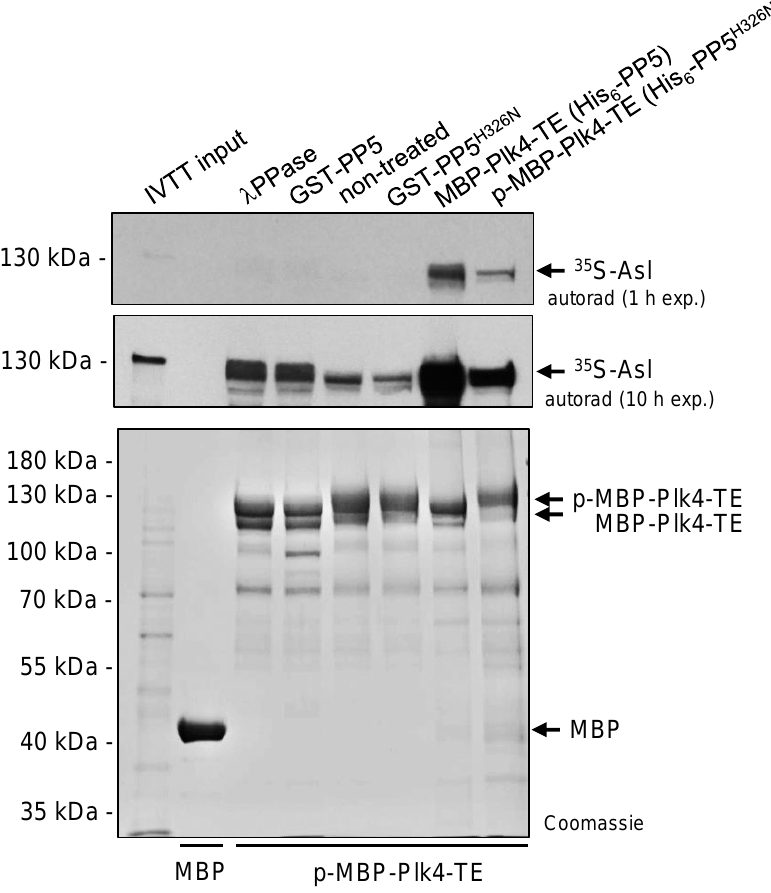
Figure 5. Asl preferentially binds to the PP5-dephosphorylated form of Plk4. Immobilized MBP- Plk4-TE was non-treated (lane 5) or treated with λ -phosphatase ( λ PPase, lane 3), GST-PP5 (lane 4) or GST-PP5 H326N (lane 6), respectively, and tested for binding to 35 S-Asl synthesized in IVTT reaction. MBP-Plk4-TE co-expressed with either His 6 -PP5 (wild type) or His 6 -PP5 H326N (inactive) in bacteria were immobilized to amylose resin and incubated with 35 S-Asl (lane 7–8). The in vitro binding assay reveals that dephosphorylated MBP-Plk4-TE binds more Asl, while the self-phosphorylated kinase binds less Asl. MBP was used as the negative control (lane 2). “p-” refers to phosphorylated Plk4. Coomassie-stained gel shows the loading and shifting of MBP-Plk4-TE derivatives. Short (1 h) and long (10 h) exposures of the autoradiographs are